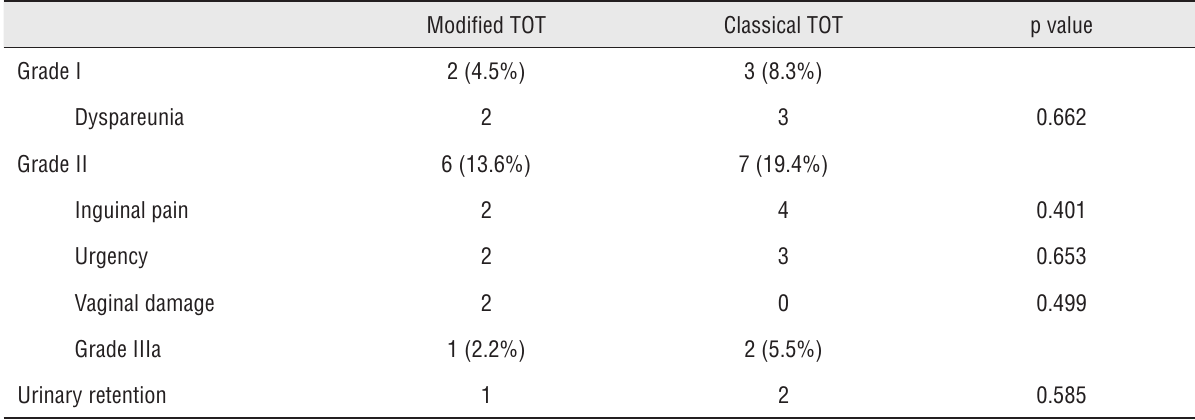
Table 2 - Complications reported according to the Clavien-Dindo